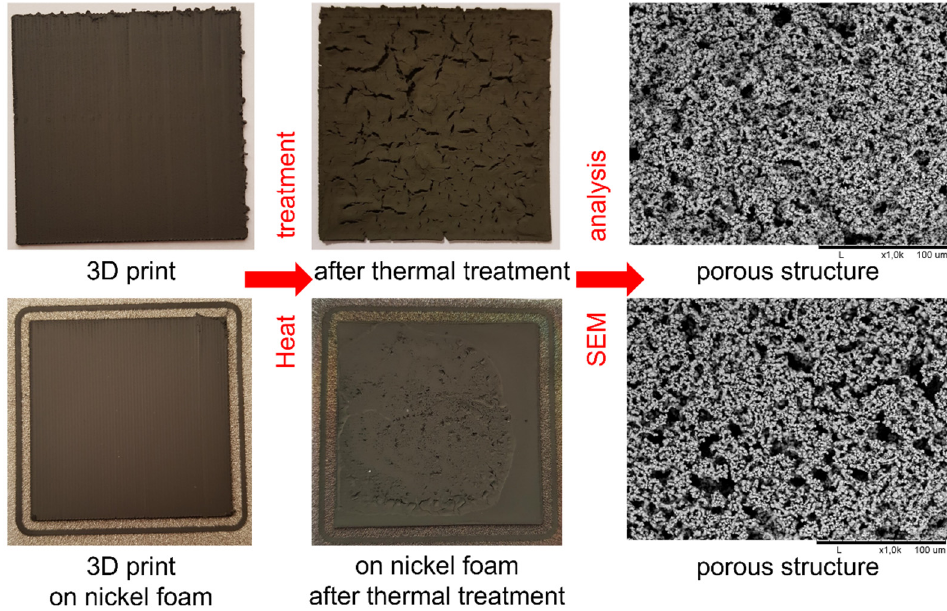
Figure 8. 3D printed sample using the ABS-Ni 25% filament ( upper images ) and similar sample printed on nickel foam ( lower images ) with images of samples after heat treatment and the corre- sponding SEM images showing the porous structures.